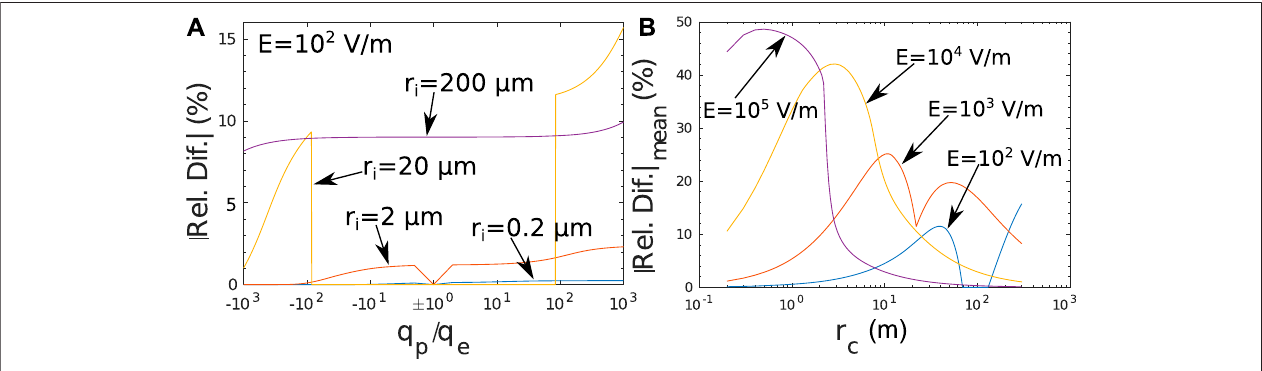
FIGURE4| Comparisonbetween Eq.30 andformulationbyLawless(1996): (A) Relativedifferenceasafunctionofnormalizedparticlecharge,fordifferentparticle radii, in the presence of external electric fi eld with magnitude 10 2 V/m, and (B) mean relative difference for a range of particle charges − 1,000 to 1,000 elementary charges, as a function of particle radius, in the presence of external fi eld with various